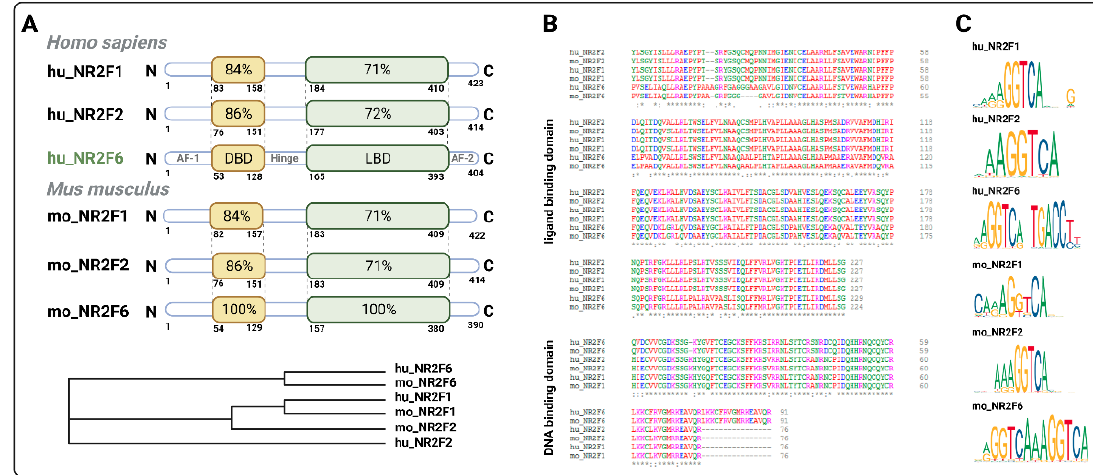
Figure 2. NR2F6 is the distantly related member of the NR2F family. ( A ) Schematic representation of the protein structure of NR2F1, NR2F2 and NR2F6 in human (hu) and mouse (mo). The different domains (AF-1–amino-terminal activation function (1) domain, DBD–DNA binding domain, hinge region, LBD–ligand binding domain, AF-2–activation function (2)) are represented by the percentage of amino acid identity among the receptors with respect to hu_NR2F6. The phylogram shown with cladogram branch length of the NR2F family defines the separation of NR2F6 from NR2F2 and NR2F1 as an early evolutionary event. Especially in the LBD, NR2F6 is significantly more divergent with homologies of 71% or 72% to the other family members, whereas NR2F1 and NR2F2 share the highest homology of 97%. ( B ) Multiple sequence alignment of LBD and DBD of mouse and human NR2F1, NR2F2 and NR2F6 (“*” = positions which have a single, fully conserved residue; “:” = conservation between groups of strongly similar properties; “.” = conservation between groups of weakly similar properties; color code: red = small; blue = acidic; magenta = basic–H; green = hydroxyl + sulfhydryl + amine + G; gray = unusual amino acids). ( C ) The GGTCA binding motif of the mouse and human NR2F family members. Programs used: Clustal Omega, Jaspar and pBLAST.